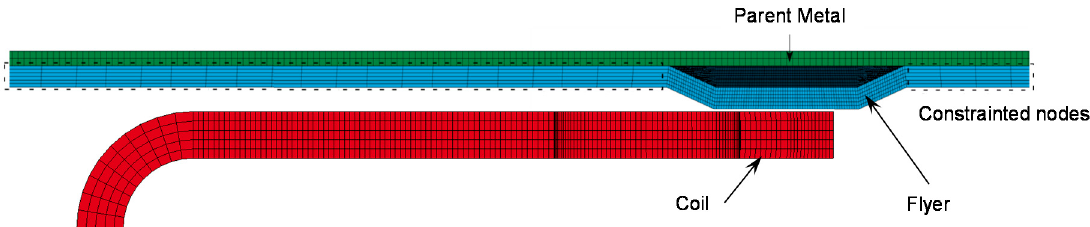
Figure 11. Model in the MPW overlapping configuration with O shape coil.